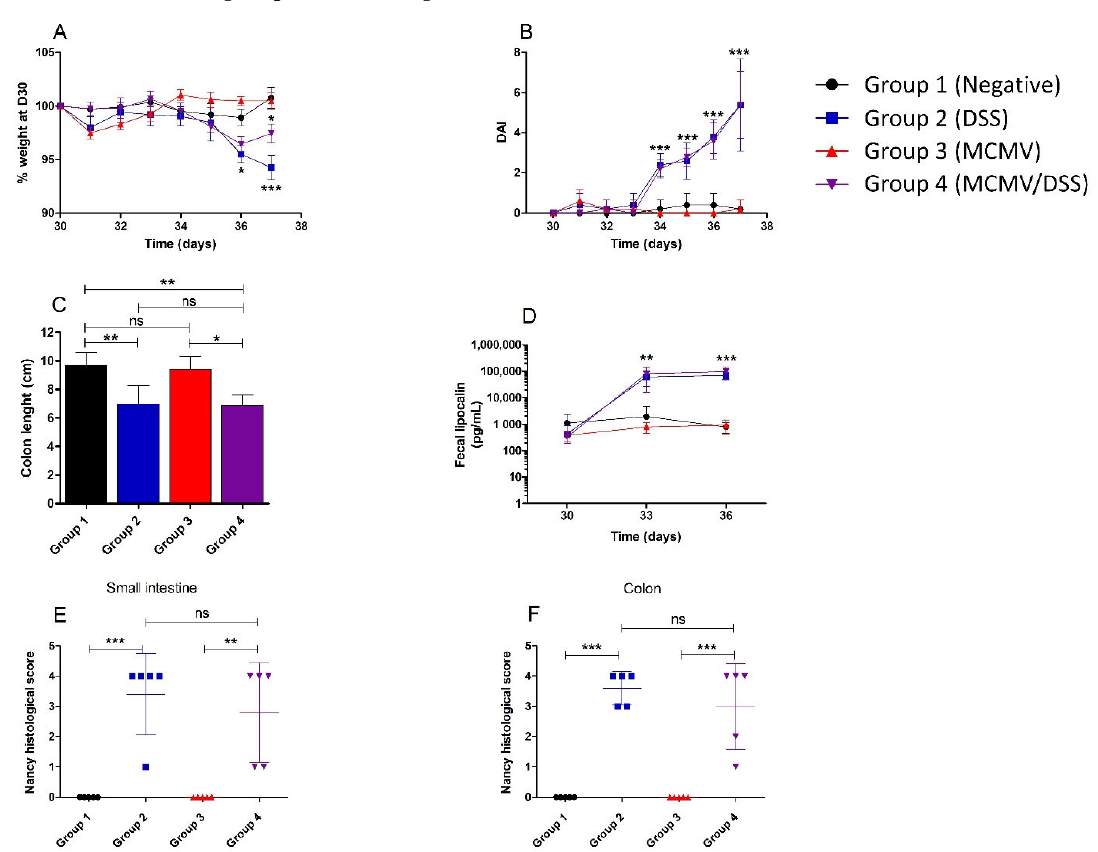
Figure 3. Monitoring of weight loss, clinical score and gut inflammation during DSS-induced colitis of MCMV-infected mice. Monitoring of clinical, biological and histopathological parameters. Mice were infected at D0 or not by murine cytomegalovirus (MCMV) and treated or not by dextran sodium sulfate (DSS) from D30 to D37 post-infection (p.i.) before being euthanized. ( A )—Longitudinal weight loss assessment from D30 to D37. ( B )—Evolution of the mean Disease Activity Index (DAI) from D30 to D37 p.i. ( C )—Length (in cm) of the colon at the time of sacrifice, expressed as a mean. ( D )—Longitudinal assessment of faecal lipocalin levels (in pg/mL) post treatment by DSS, values are expressed as means. ( E )—Determination of the Nancy histological score (from 0 to 4) of the small intestine specimen from individual mice at sacrifice (D37 p.i.). ( F )—Determination of the Nancy histological score (from 0 to 4) of the colon specimen. Statistical tests that were used were a two ‐ way ANOVA with Bonferroni correction for panels A, B and D, and a one ‐ way ANOVA for panel C, E and F. ns: not statistically significant, * p < 0.05, ** p < 0.01, *** p < 0.001.